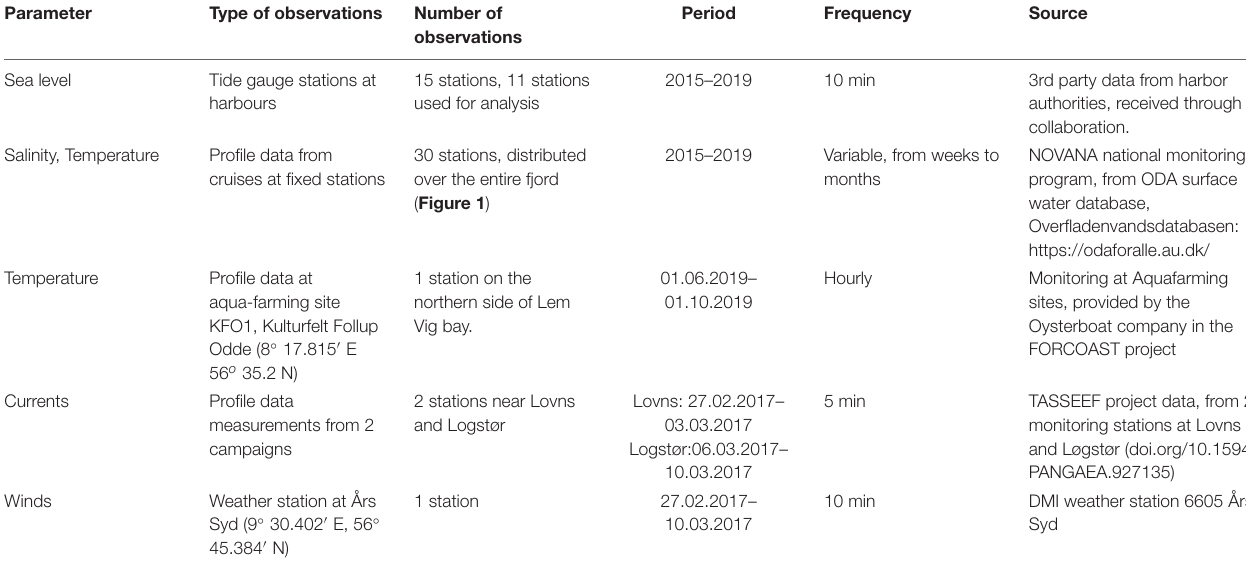
TABLE 2 | List of data sets used for model